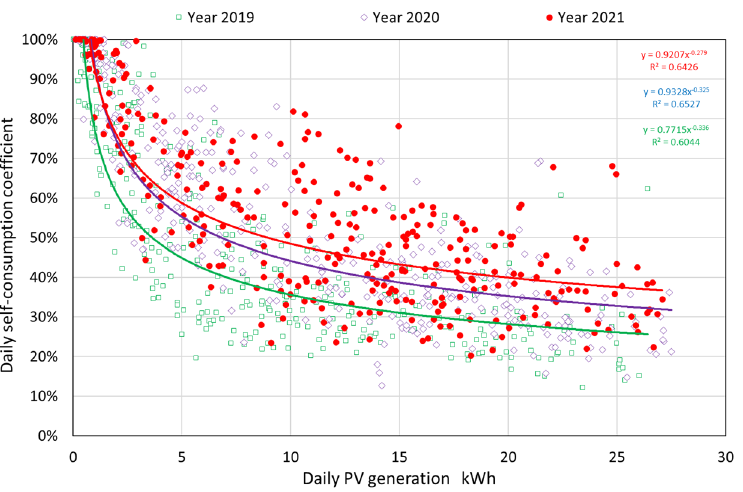
Figure 9. Influence of the daily PV generation on the SC.